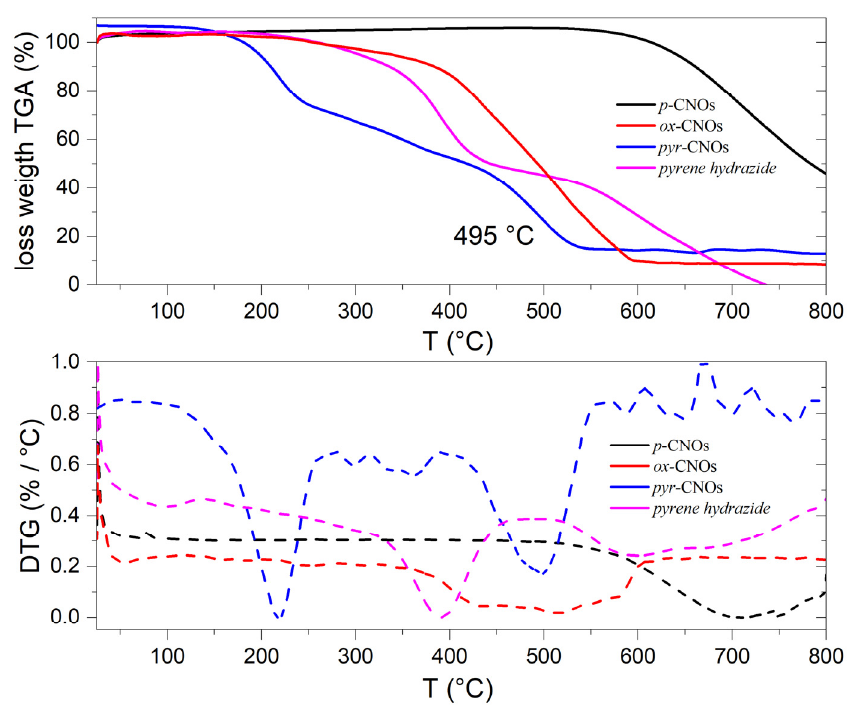
Figure 6. TGA curves of the functionalized and non-functionalized CNOs ( top ) and pyrene hydrazide under an air atmosphere. The first derivative of the corresponding TGA curve ( bottom ).